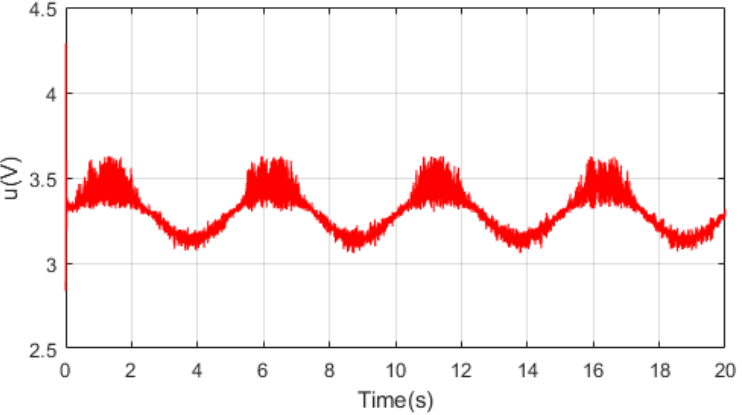
Figure 30. Control signal applied by the reference model control for the sinusoidal